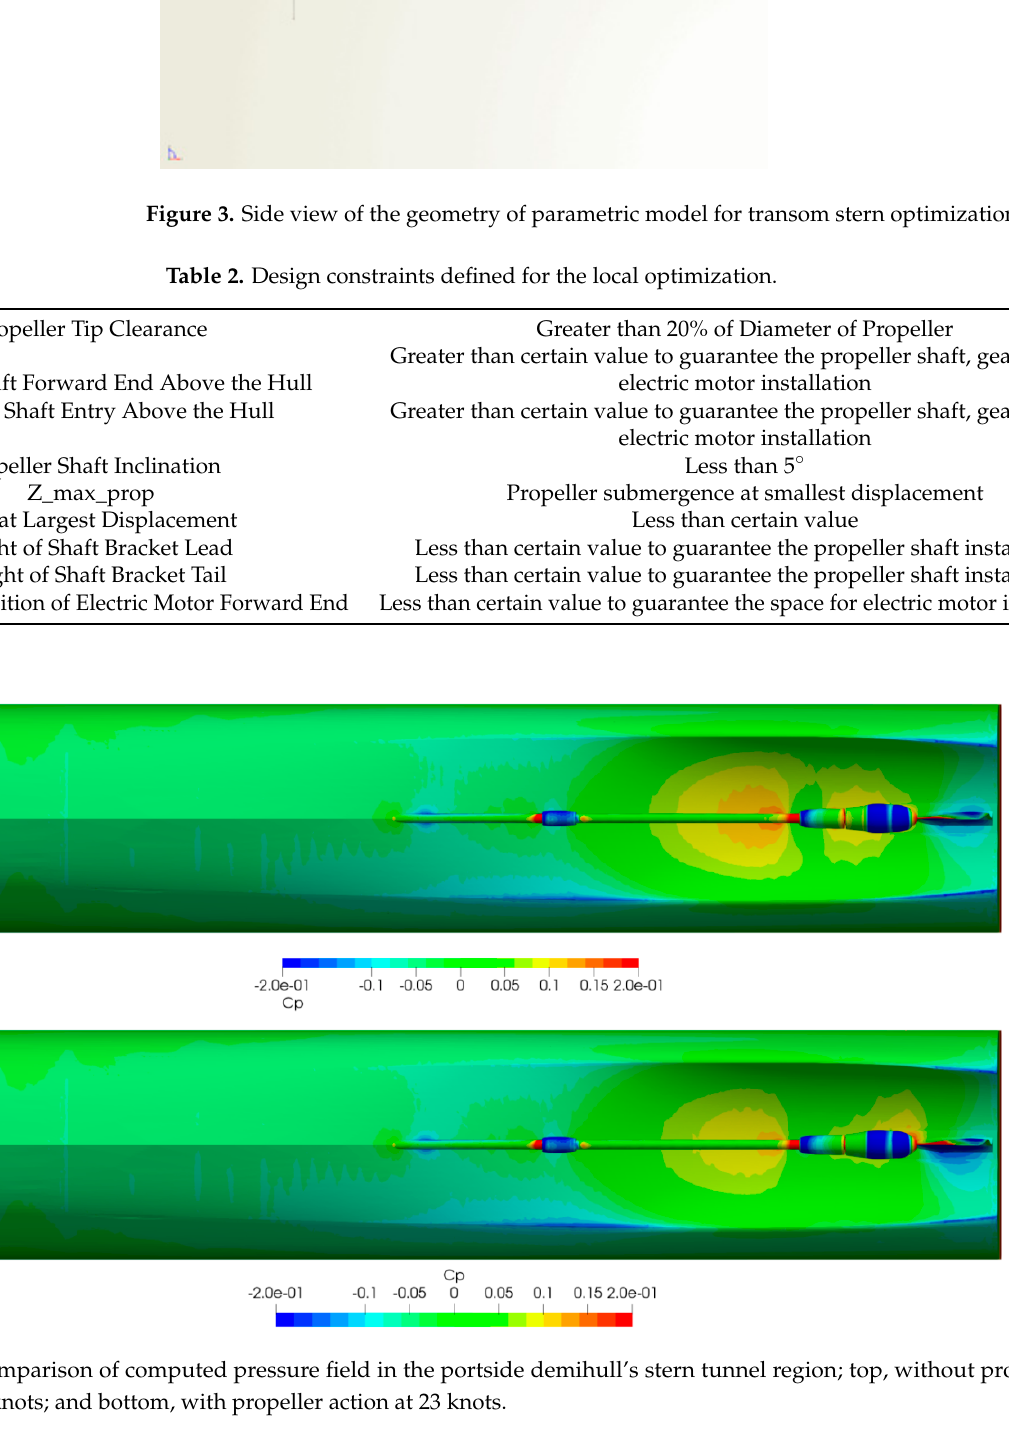
Figure 5. Computed streamlines in the stern tunnels and passing the propellers discs. 3. Experimental Verification and Validation of Numerical Results For the validation of the numerical predictions of the calm water performance of the TrAM Stavanger demonstrator, a prototype of which is presently in the production stage, a large model of 5.34 m in length (scale 1:5.6) was tested in the large towing tank of HSVA (300 m length × 18 m width × 5.6 m depth). The tested large model allowed very precise measurements, while minimizing scale effects. The large width of the towing basin mini- mized wall refection effects on the catamarans wave resistance. The model test results were analyzed by use of HSVA’s Standard Correlation Method, which is in accordance with Froude's method. The demihull models were manufactured out of thin layer wood and were cross-connected by high-strength metal beams. A view of the tested model un- der way at Froude 0.69 (23 knots full scale speed) and a close-up of a demihull’s stern area with the fitted CP propeller, shaft, brackets and (twisted) rudder is shown in Figure 6.